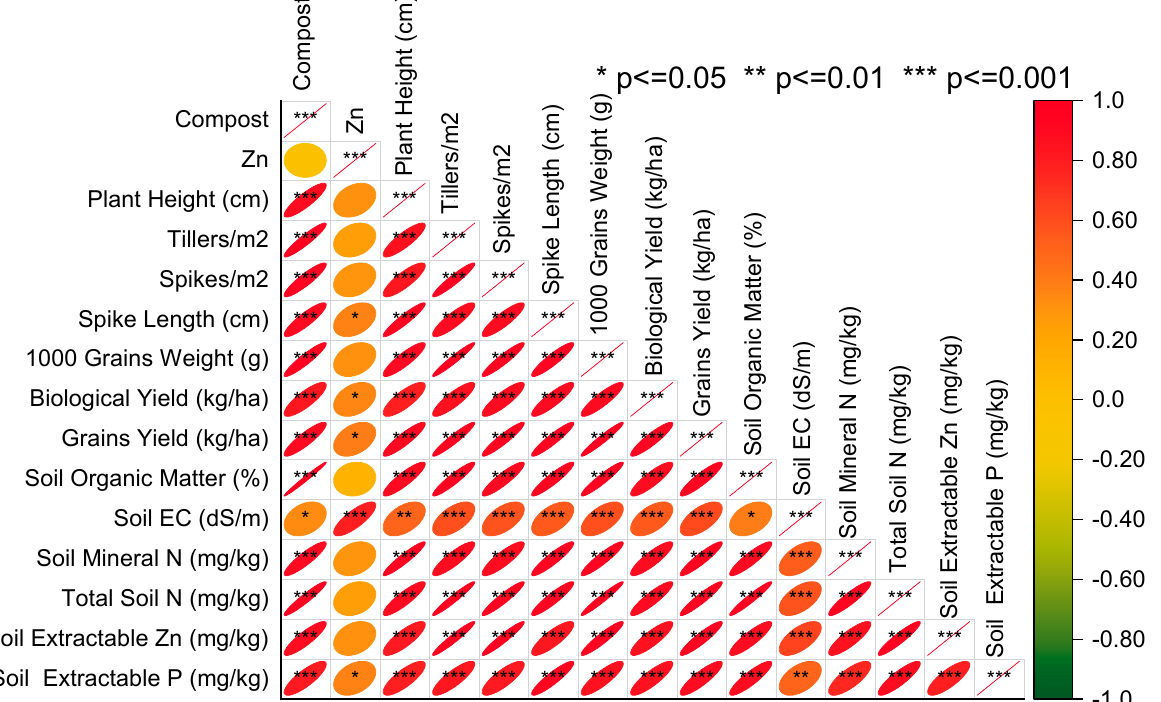
Figure 5. Pearson correlations for different studied attributes. Red and reddish-yellow colors indicate positive correlations, while yellow and yellowish-green colors indicate negative correlations.